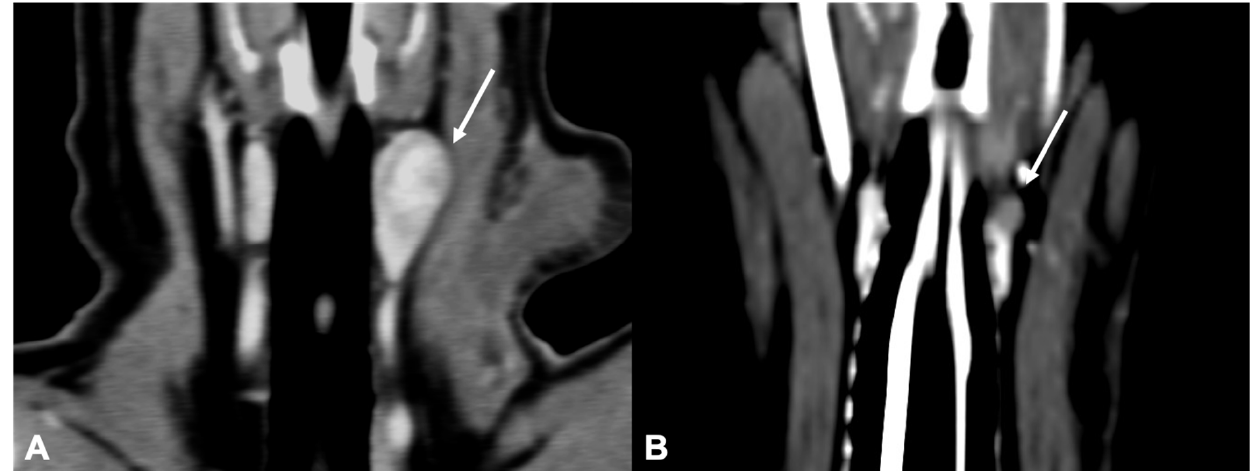
Figure 4. CT appearance of parathyroid gland adenocarcinoma. Post-contrast dorsal CT reconstruc- tion in two dogs with parathyroid gland adenocarcinoma (arrow) at the level of the left external parathyroid. Note the variable CT appearance: large size of the lesion in ( A ) showing heterogeneous contrast enhancement; the adenocarcinoma in ( B ) is smaller, has a rounded shape, and homogeneous contrast enhancement.